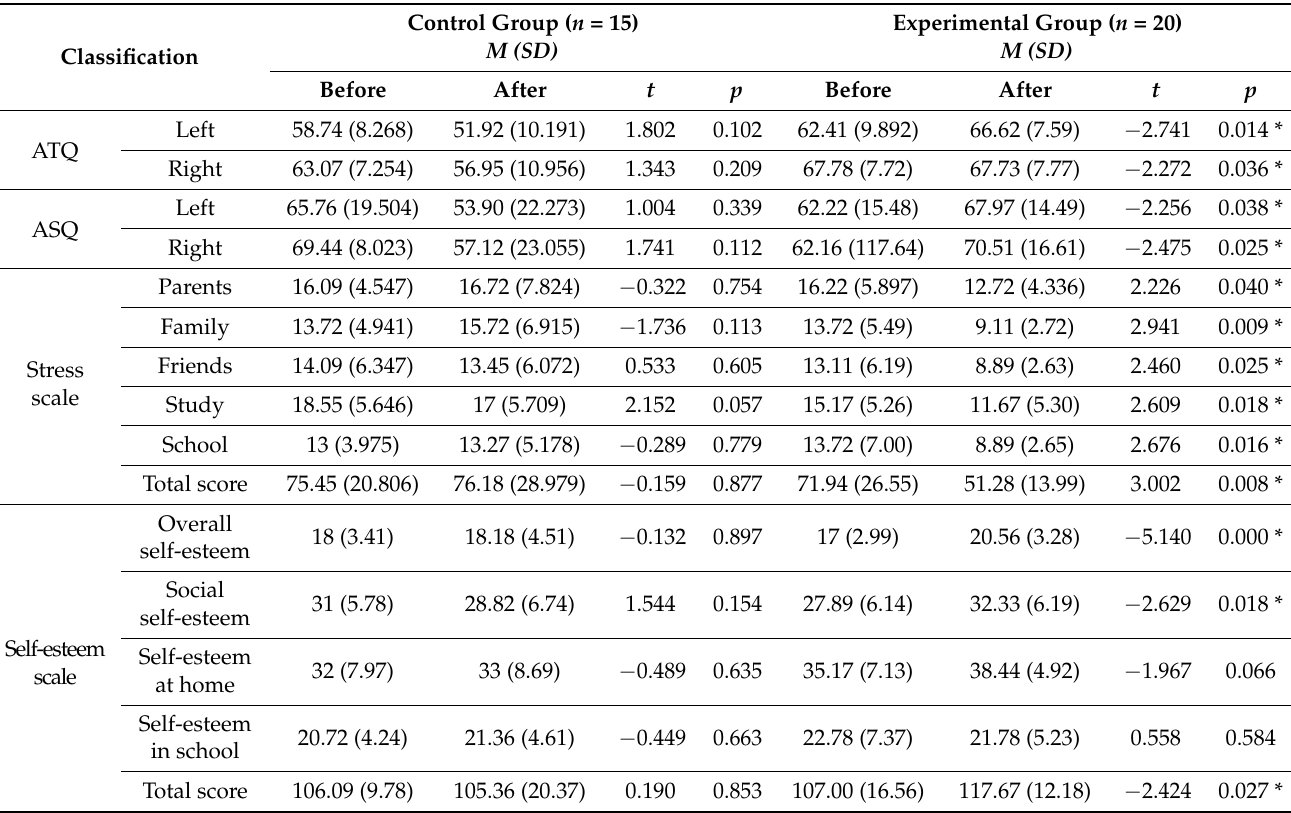
Table 5. Changes in the ATQ, ASQ, stress, and self-esteem scales of the experimental and control groups.